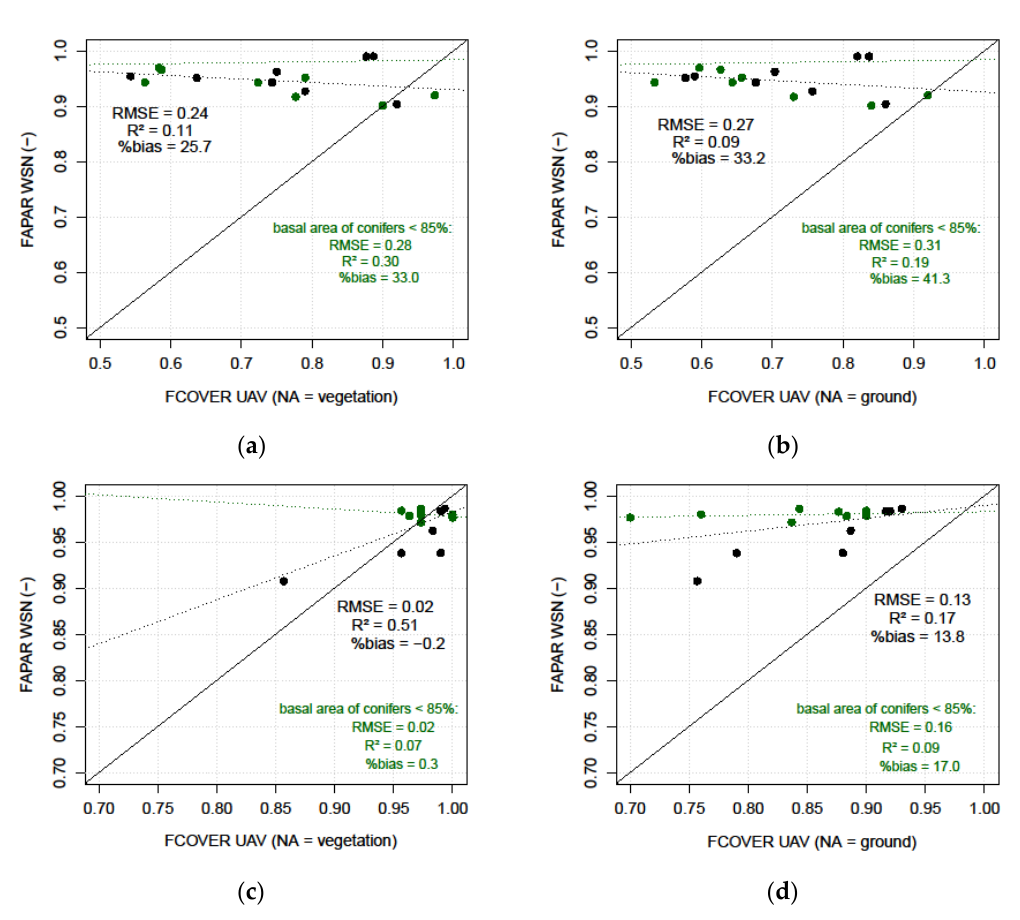
Figure 11. In situ FAPAR plotted against ( a ) FCOVER-UAV NA=veg and ( b ) FCOVER-UAV NA=ground at the spring acquisition date, as well as ( c ) FCOVER-UAV NA=veg and ( d ) FCOVER-UAV NA=ground at the summer acquisition date. The dot colors refer to species composition at different sensor locations (black: conifer-dominated, green: higher percentage of deciduous species).